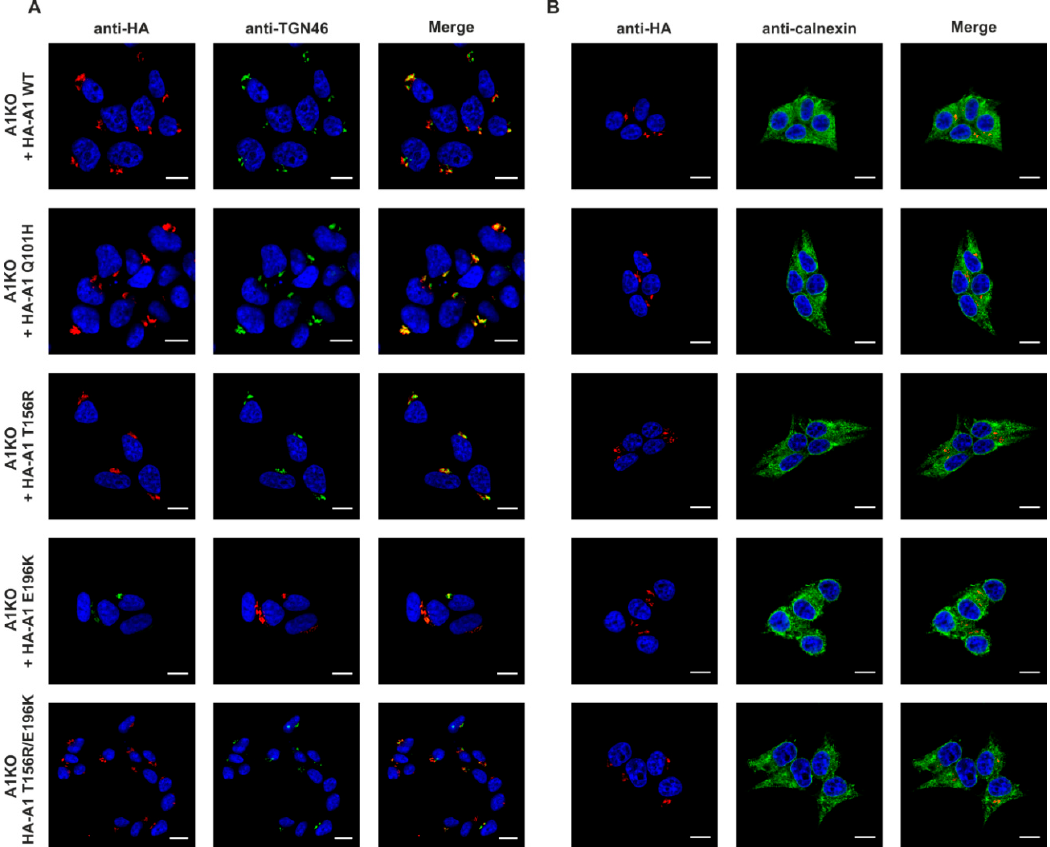
Figure 2. Analysis of subcellular localization of the wild-type and disease-causing CST variants. CST-deficient HEK293T cells overexpressing recombinant CST variants were subjected to indirect immunofluorescent staining with anti-HA (red) and anti-organelle marker (green) antibodies (( A ), counterstaining of the Golgi apparatus; ( B ), counterstaining of the ER). Cell nuclei were counterstained with 4 ′ ,6-diamidino-2-phenylindole ( DAPI). Scale bar = 10 μ m. TGN46, trans-Golgi network integral membrane protein 2. A1, SLC35A1.